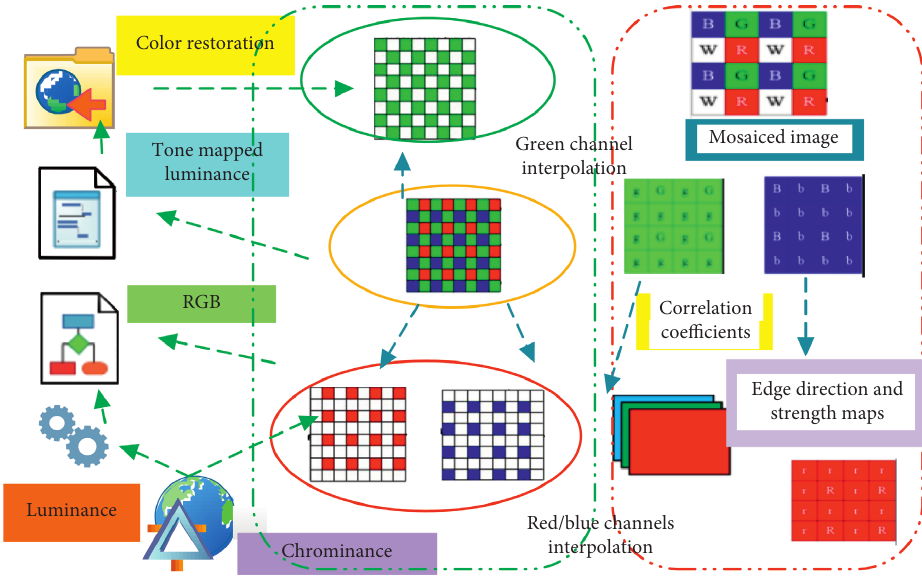
Figure 1: The combination of animation composition and tone space conversion